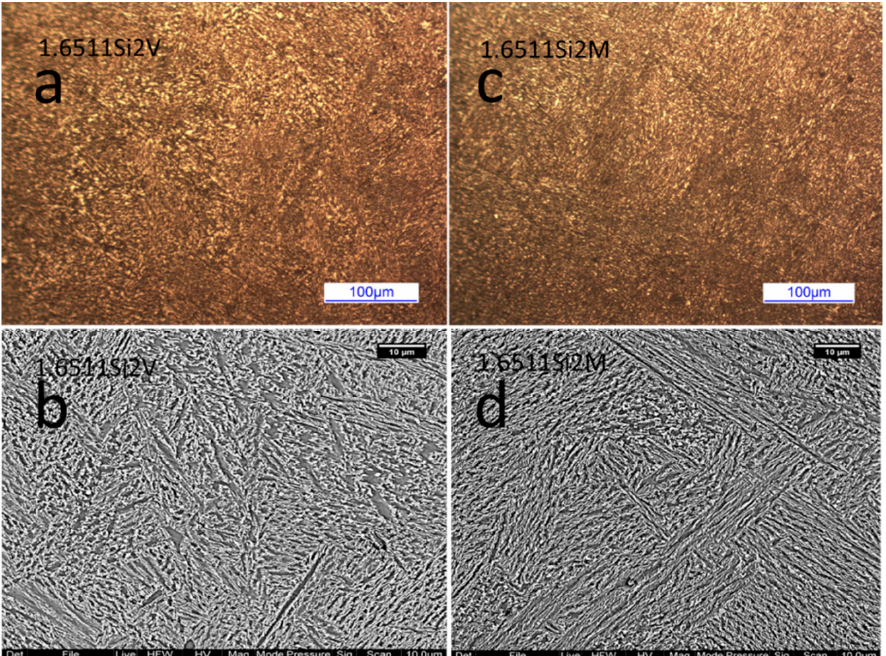
Figure 7 . Optical and electron metallography of 1.6511Si2V ( a , b ) and 1.6511Si2M ( c , d ) after austempering at 300 °C. Note: All samples have CFB matrix.